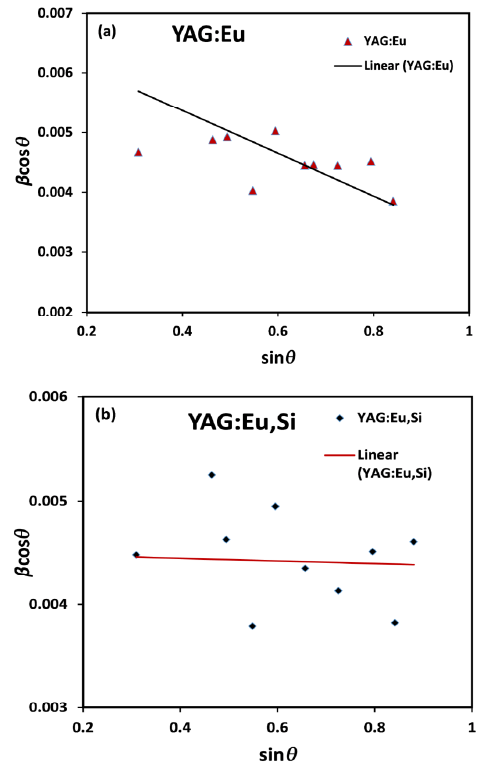
Fig. 2 Williamsons–Hall plots for phosphors.